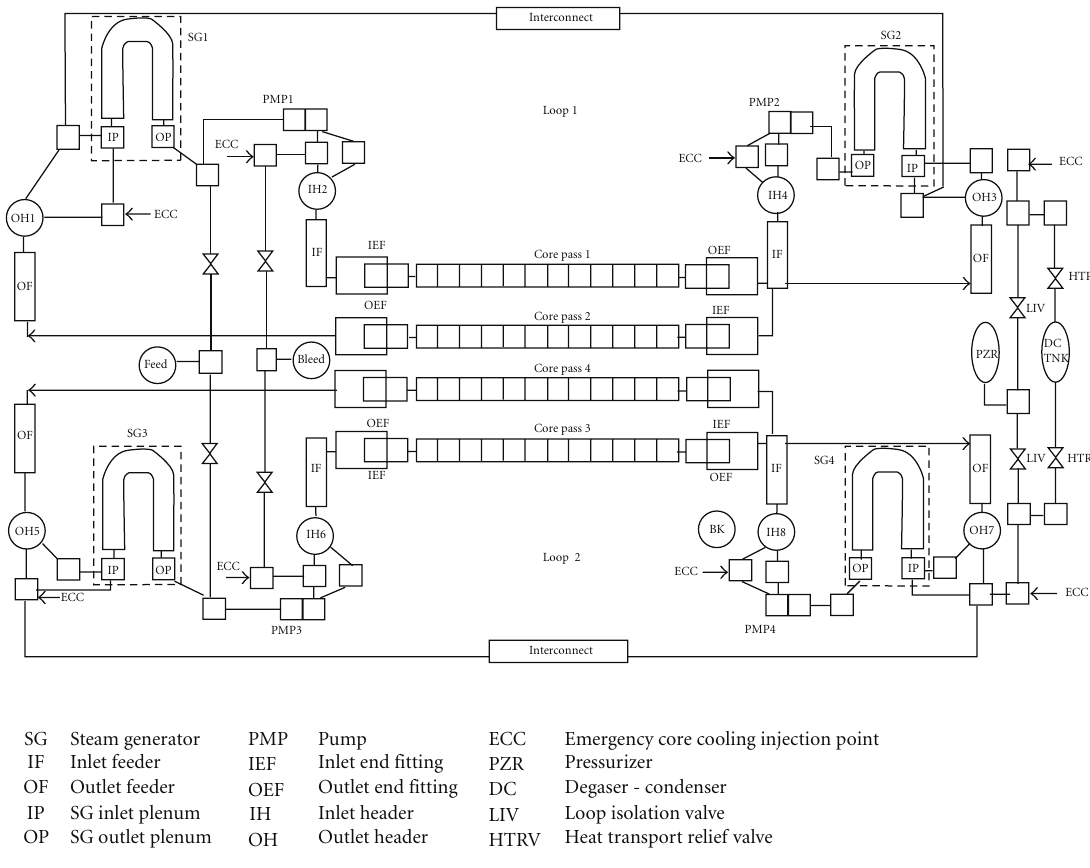
Figure 13: RELAP5 thermal hydraulic nodalization for CANDU-6.